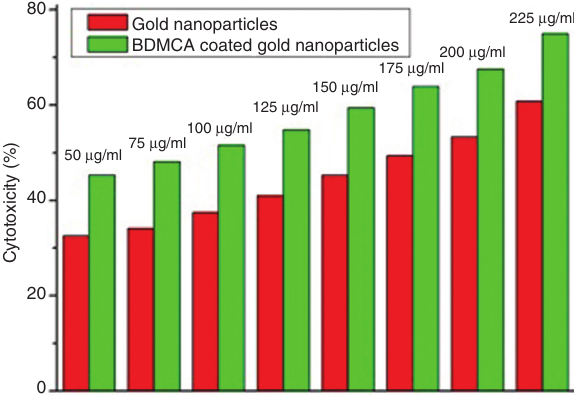
Figure 13 Cytotoxicity of gold nanoparticles and bisdemethoxycur- cumin analog (BDMCA) coated gold